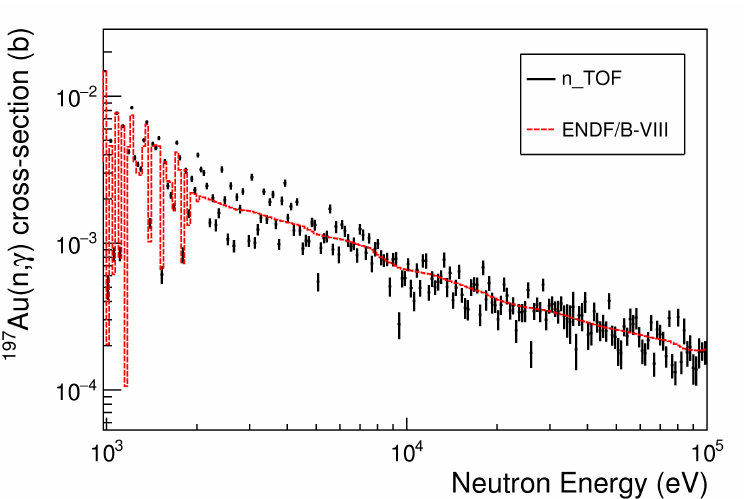
Figure 4. Experimental 197 Au(n, γ ) cross-section (black dots) compared to the evaluation of ENDF/B- VIII (red dashed